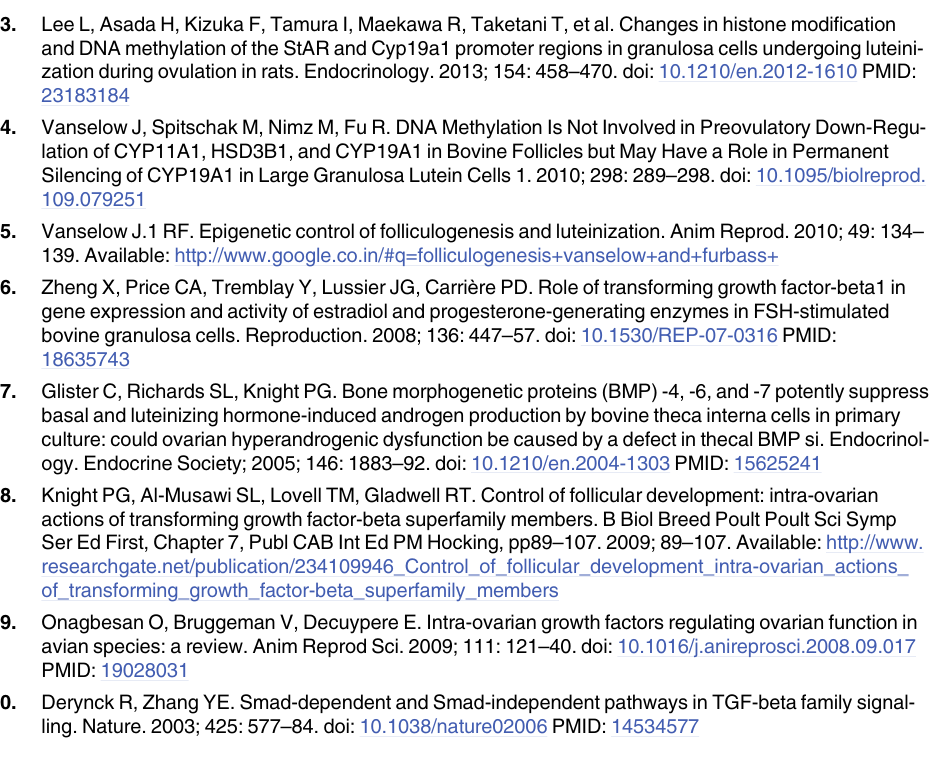
PLOS ONE | DOI:10.1371/journal.pone.0146028 December 30,